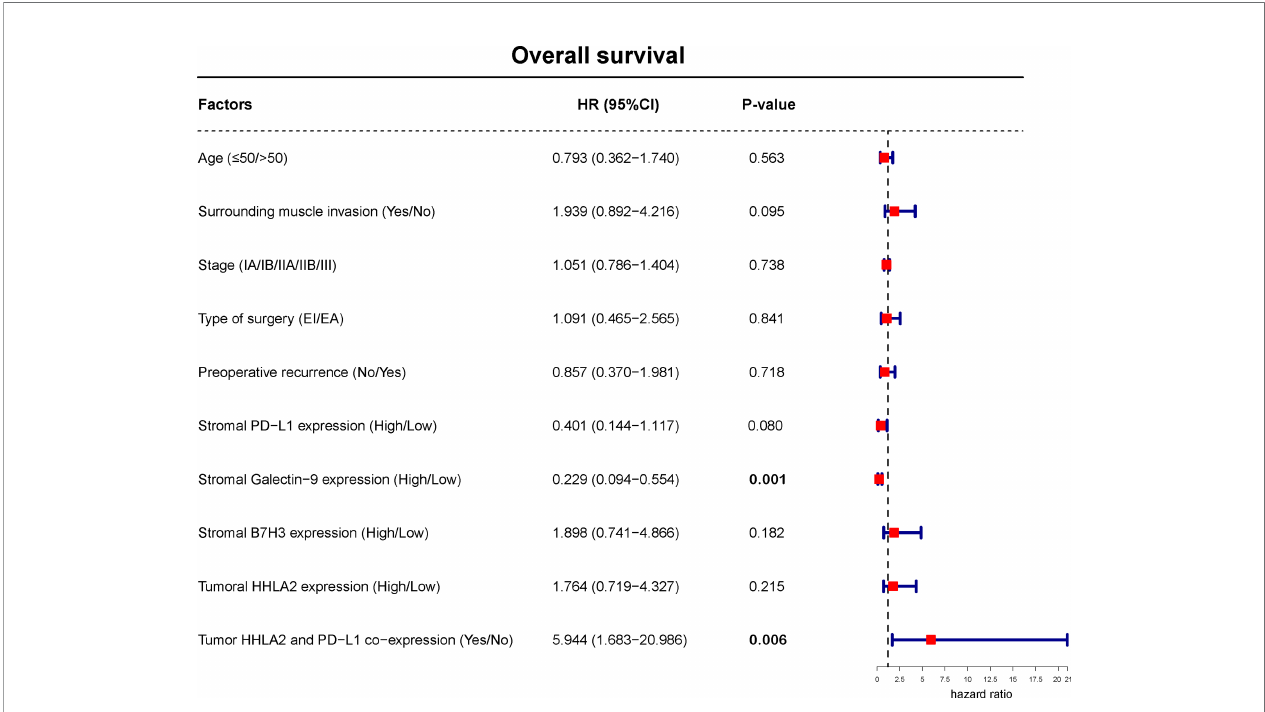
FIGURE 12 | Multivariate Cox regression model including factors that were signi fi cant in univariate analysis for OS of spinal chordoma patients. The boxes indicate the hazard ratio, and the horizontal lines represent the 95% CI. Factors found to independently predict LRFS had P values in bold (less than 0.05). OS, overall